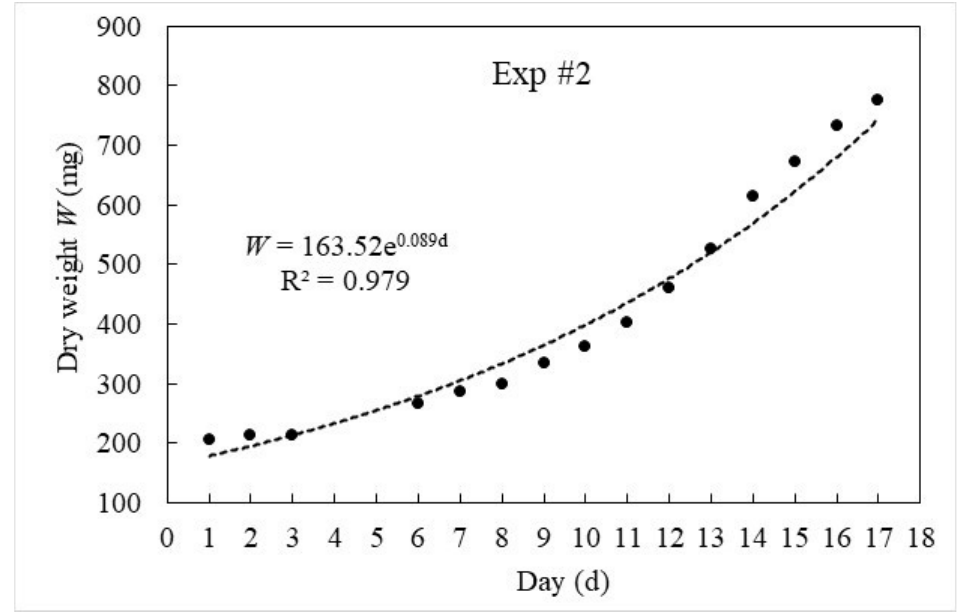
Figure 2. Aurelia aurita . Increase in dry weight of jellyfish fed 50 Artemia l − 1 . The b -exponent of the exponential regression equations shows that the mean weight-specific growth rate is 8.9% d − 1 .